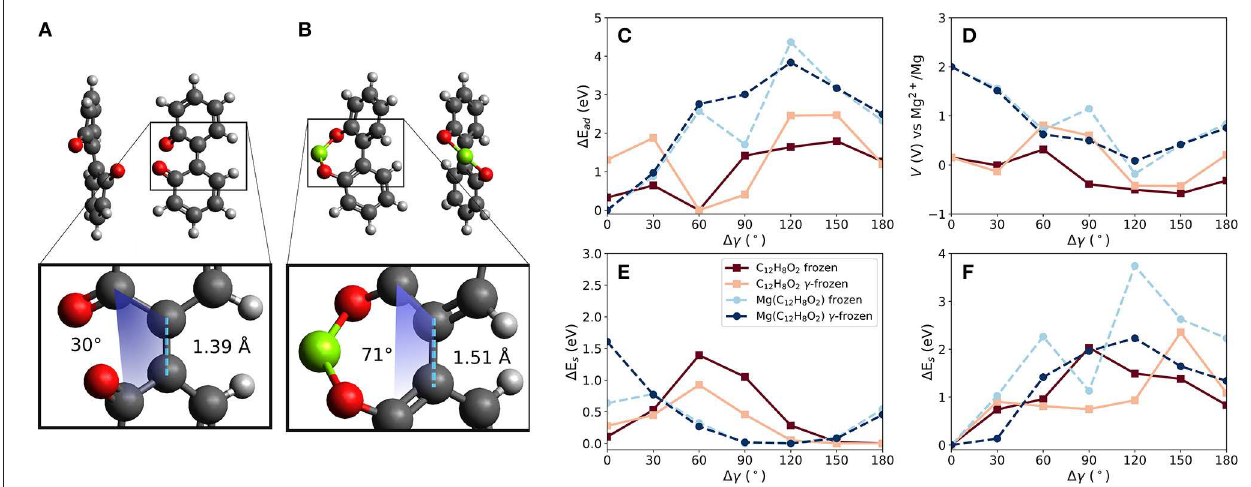
FIGURE 4 | Effects of dihedral angle change in a biphenyl-like molecule with two carbonyl groups (BipO2) at connected phenyl-like rings. Differences in bond lengths between phenyl-like rings and dihedral angle γ in (A) BipO2 after Mg detachment and (B) MgBipO2, i.e., BipO2 with one attached Mg atom. (C) Change of interaction strength between Mg and the molecule for frozen and partly frozen, i.e., γ -frozen, relaxations based on the optimized BipO2 structure, as shown in (A) , red curves, and based on MgBipO2, as shown in (B) , blue curves. The computed voltages are shown in (D) . The strain energies given in (E) and (F) are computed without and with one attached Mg atom,